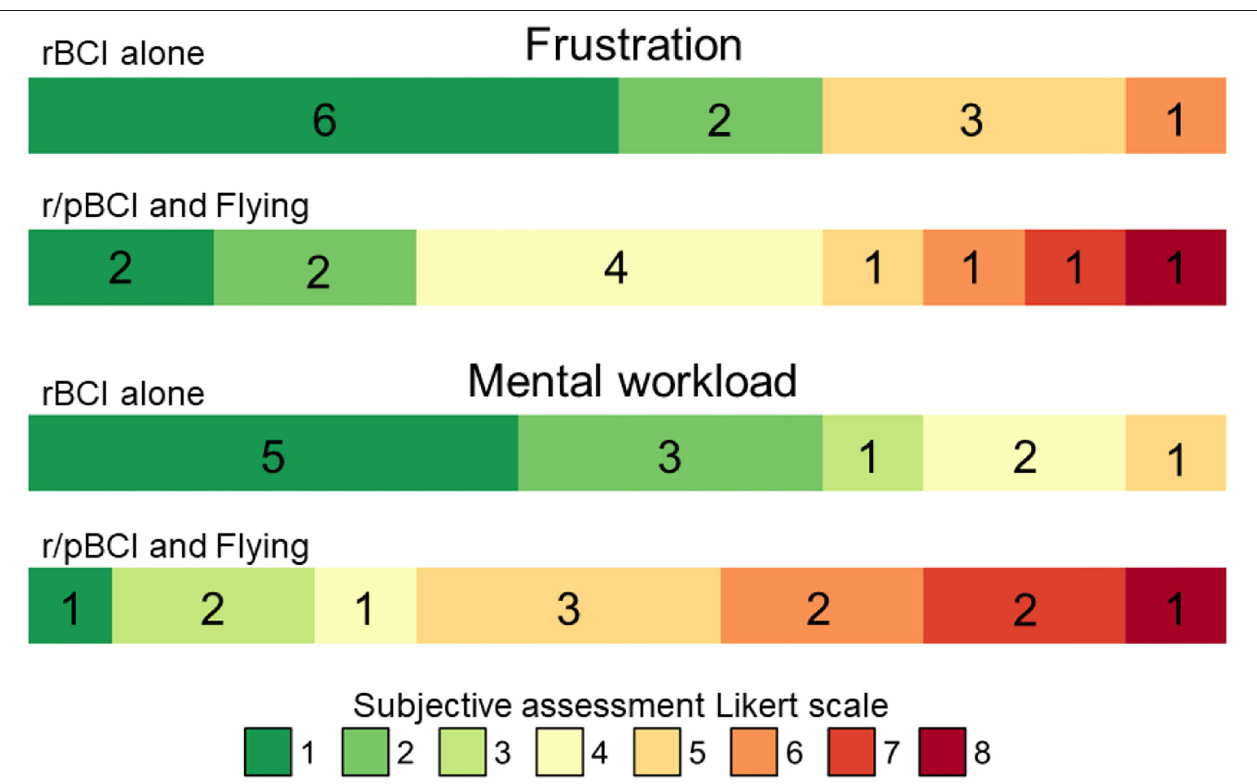
FIGURE 4 | Questionnaire responses of the participants to statements regarding frustration and mental workload in the two conditions. The width of the bars and the numbers inside them reflect the number of participants that provide a certain rating on the Likert scale for the associated question (1–8). Lower scores (represented in green) indicate a better user experience whereas higher scores (represented in red) are associated with negative experiences (higher mental workload and frustration).